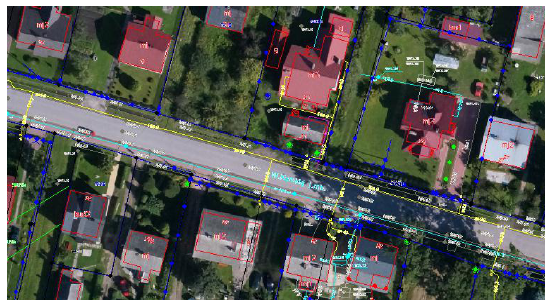
Figure. 3 Updated basic map based on UAVs